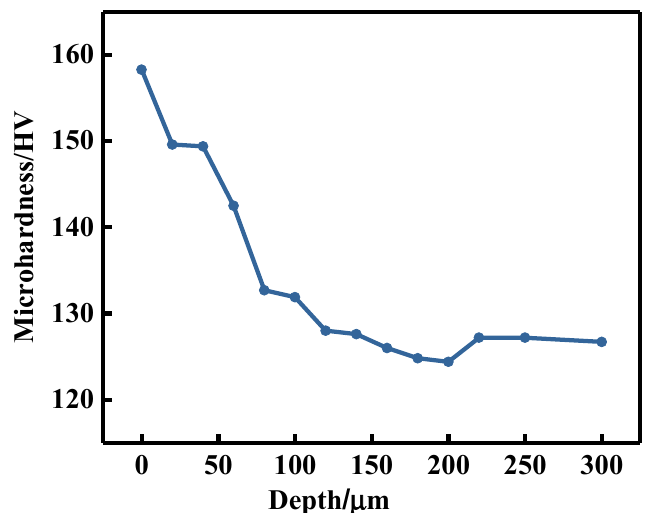
Figure 7. Hardness curve of shot-peen-forming sample varying with depth.